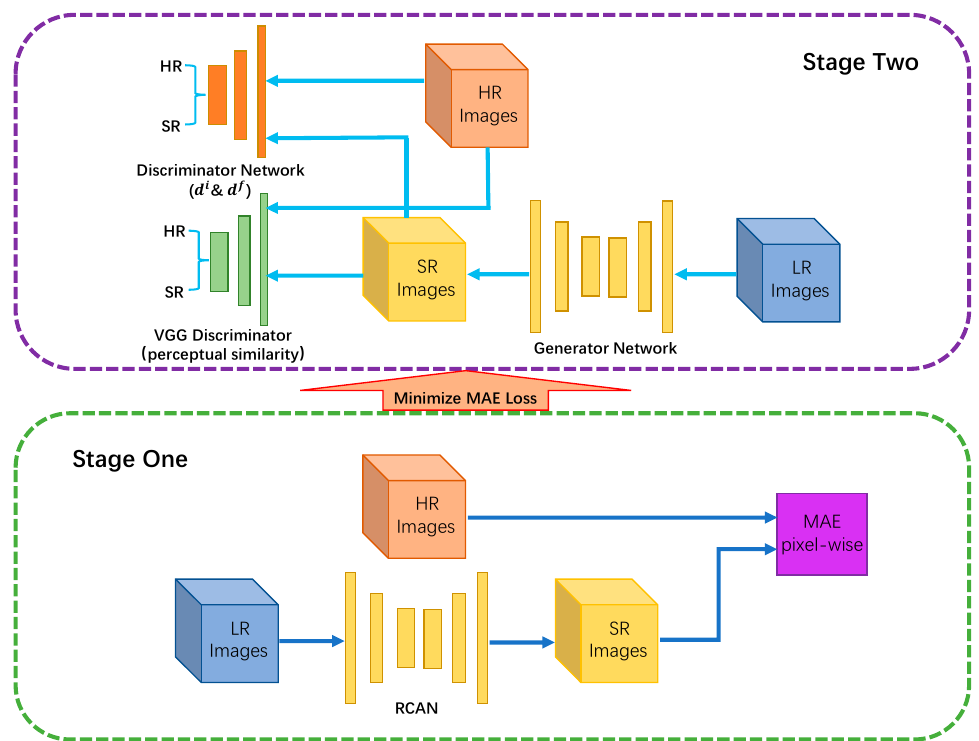
Figure 3. Data flow and system functional diagram of our approach. The dark blue line represents the data flow in stage one, as well as the light blue line represents the data flow in stage two. When MAE loss is minimized in stage one, it runs into stage two.